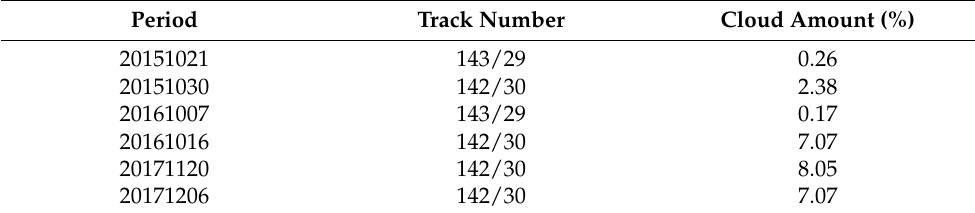
Table 1. Landsat 8 data